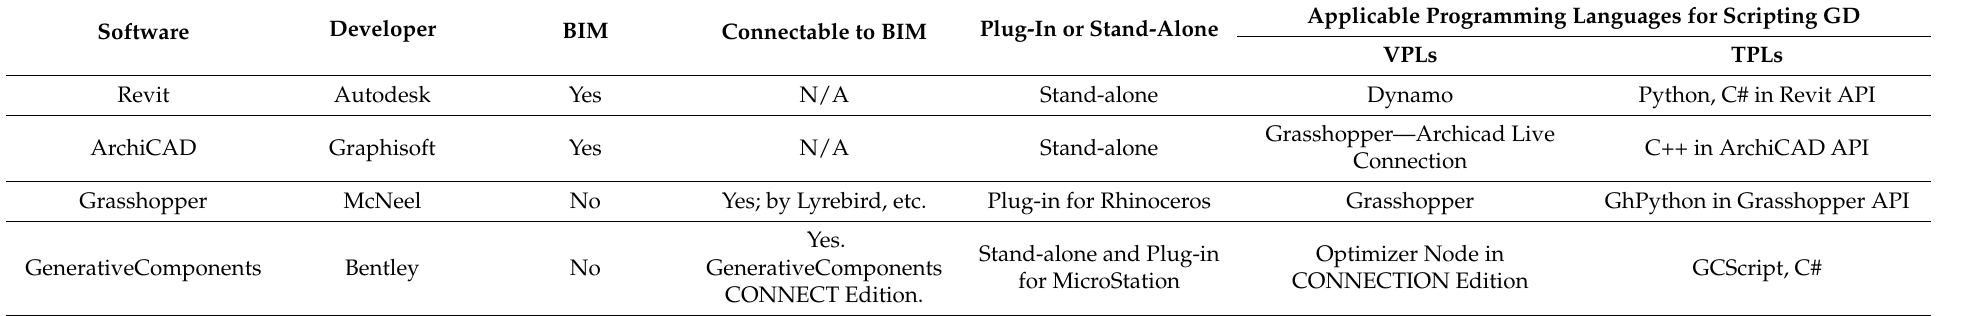
Table 4. Commonly used software and applicable programming languages for scripting